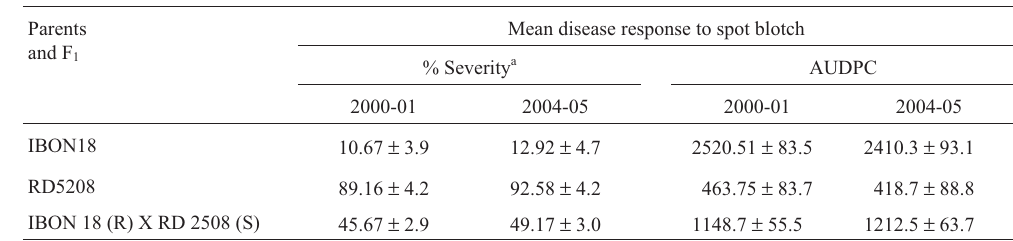
Table2 -MeanpercentagespotblotchscoresandAUDPCwithstandarderrorsforresistantandsusceptibleparents,aswellasF 1 usedinthegeneticanal-